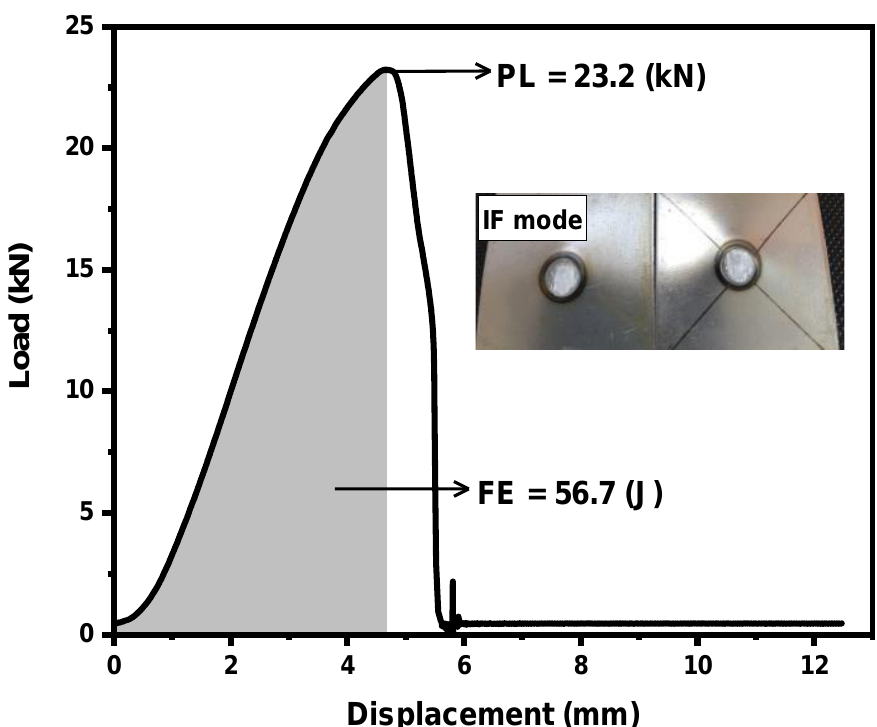
Figure 5. Load–displacement plot of SPW indicating peak load (PL) and failure energy (FE).